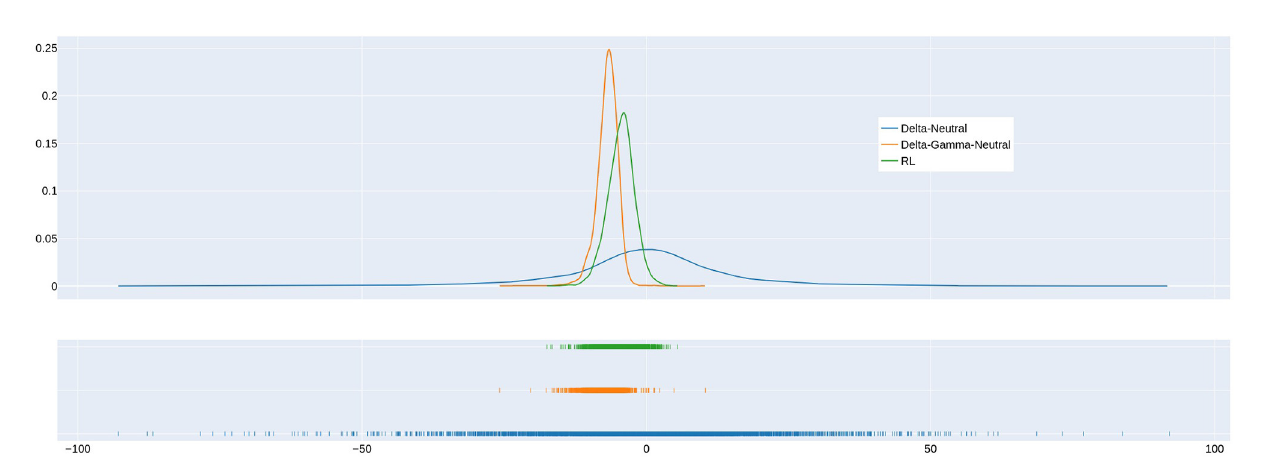
FIGURE2 Comparison of gain distribution for delta hedging, delta-gamma-neutral hedging, and hedging by the VaR95 RL agent when transaction cost that the 5 th percentile of the gain distribution corresponds to the 95th percentile loss in Table